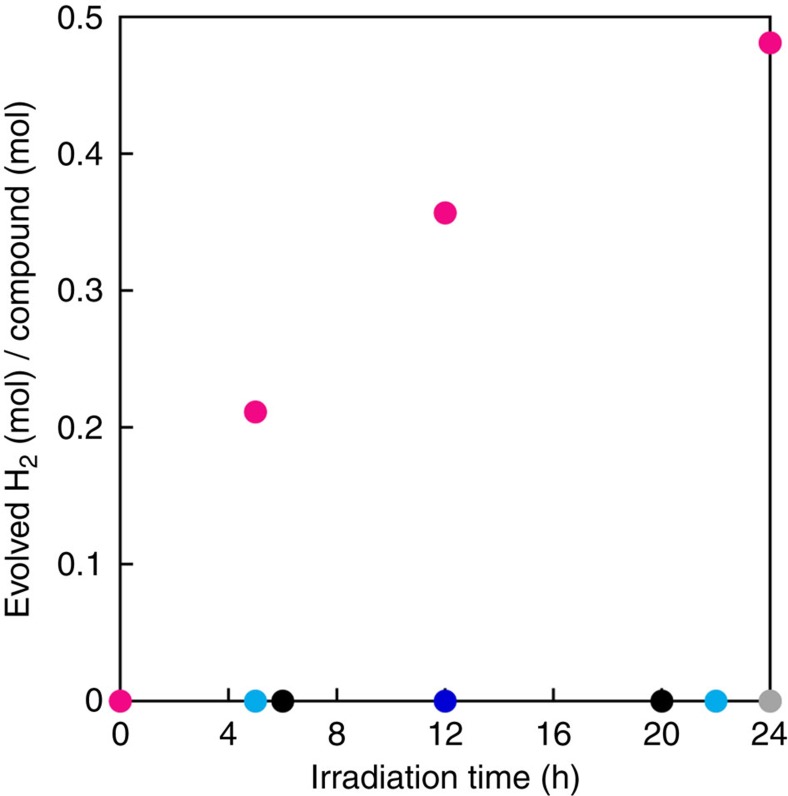
H2 evolution from a MeOH solution of 1.Mols of evolved H2 per mol of catalyst as a function of PHER time for MeOH solutions of apH2 (2 mM; black circles), apH− (2 mM; turquoise circles), 1 (1 mM; magenta circles) and FeII(ClO4)2·6H2O (1 mM; blue circles), together with pure MeOH (grey circles). Irradiation wavelength, 350±10 nm (21.8 mW). Estimated relative s.d., 5%.